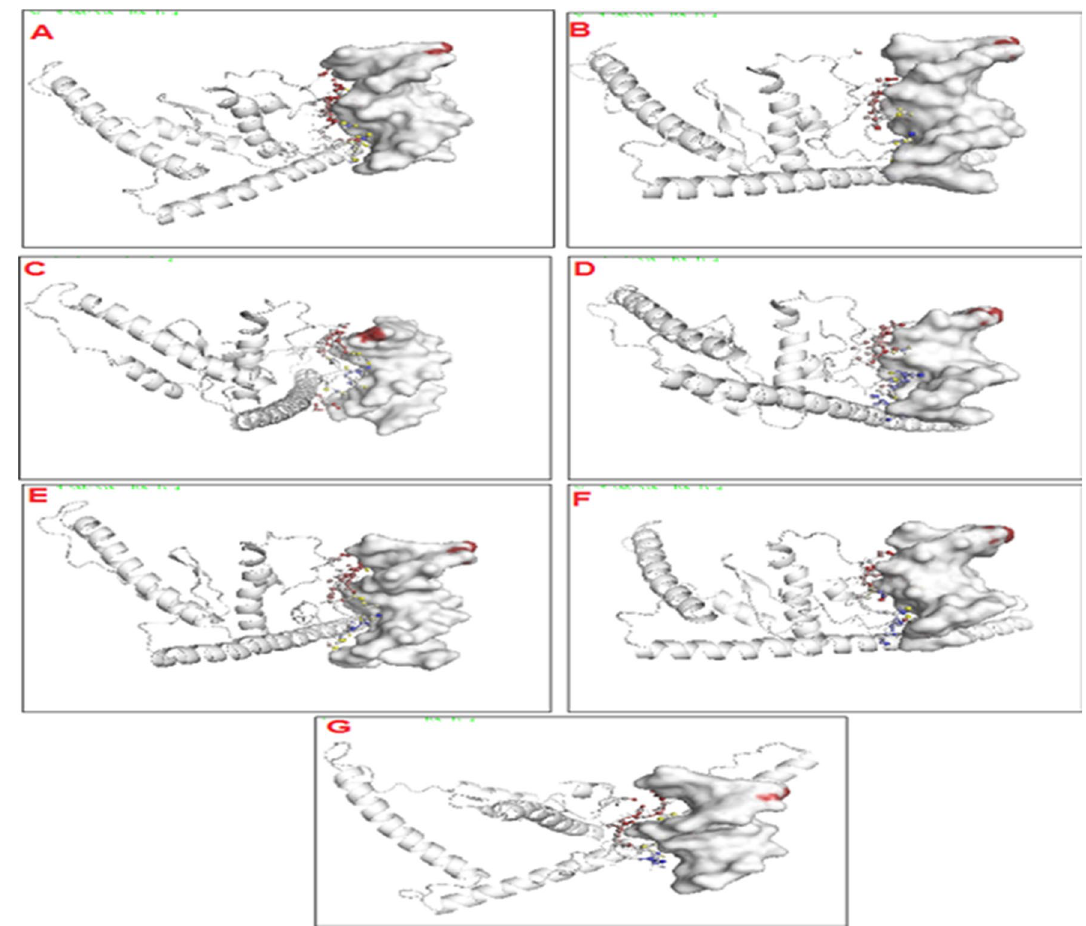
Figure 6. Protein-DNA interface visualizations created by PyMOL plugin PDIviz The sugar-phosphate backbone interface (DNA backbone atoms and protein atoms interacted with them) coloured in red, the DNA bases interface coloured in blue, and atoms/areas involved in simultaneous interaction with DNA bases and backbone coloured in yellow. ( A ) AGl42–EDF1 DNA backbone and bases complex. ( B ) AGL42-EDF2 DNA complex. ( C ) AGl42- NAC8 DNA binding domain complex. ( D ) AGL42—NAC9 DNA complex. ( E ) AGL42— NAC12 DNA binding domain complex. ( F ) AGL42—NAC14 DNA complex. ( G ) AGL42—NAC17 DNA binding domain